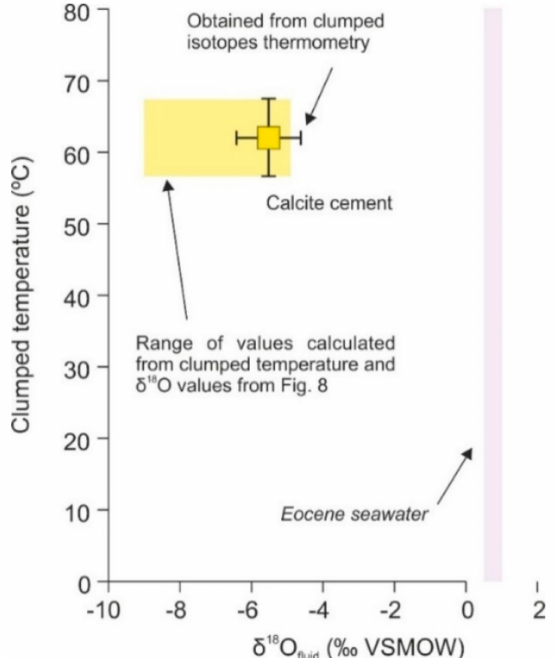
Figure 9. Clumped isotopes temperature in ◦ C vs. calculated δ 18 O fluid (% (cid:24) VSMOW) for the bladed calcites. The yellow box indicates the range of δ 18 O fluid calculated from the δ 18 O values of bladed calcites in Figure 8 in % (cid:24) VPDB and the measured clumped isotopes temperature, using the formula of [80]. δ 18 O of Eocene seawater in % (cid:24) VSMOW is from Reference